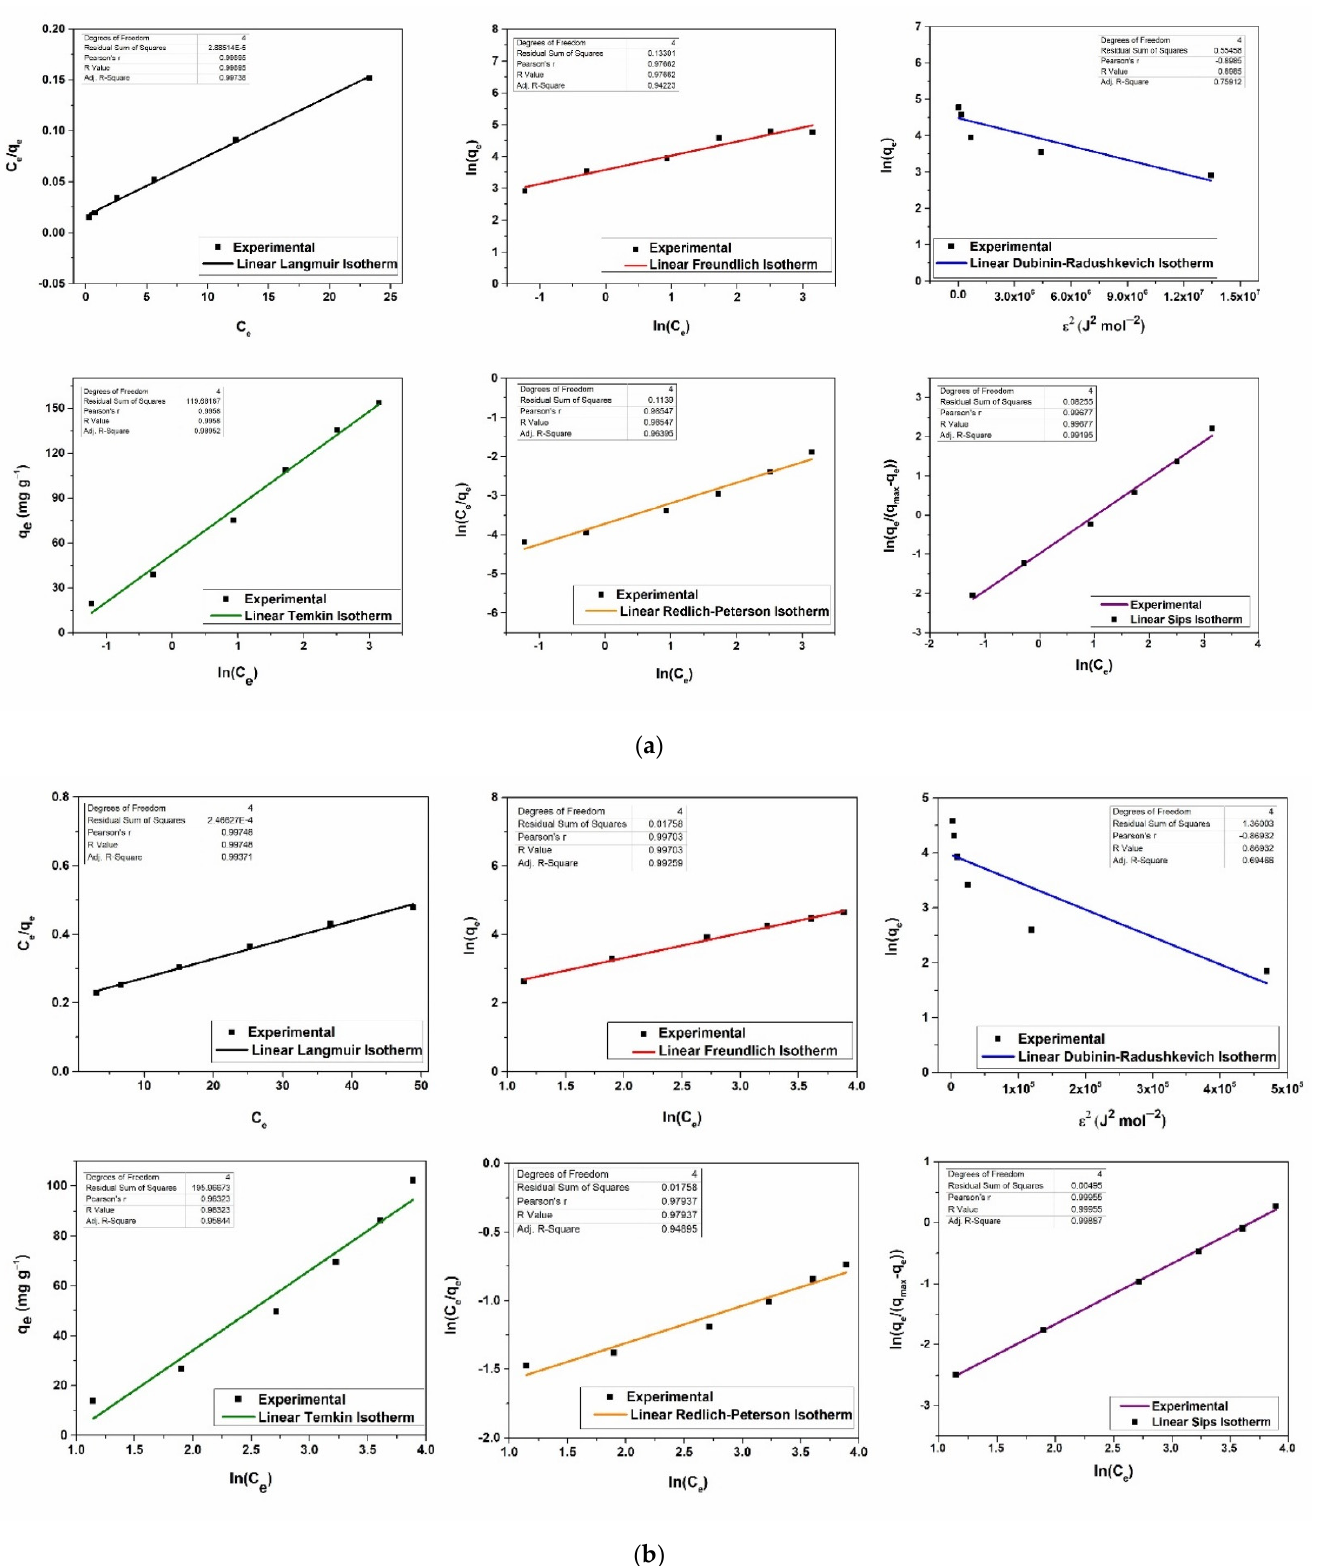
Figure 10. Linear forms of the equilibrium isotherms obtained for ( a ) Pb and ( b ) Cd adsorption onto CHIT-PAAA.